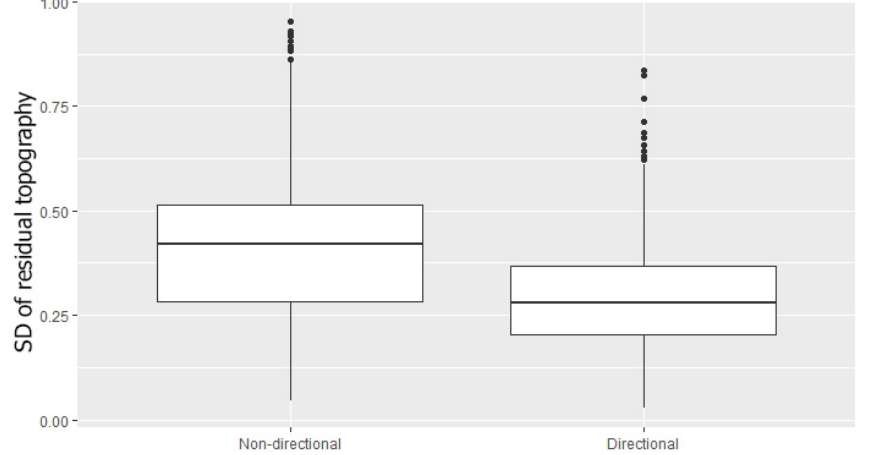
Figure 6. Surface roughness values calculated using non-directional and directional SD of residual topography. Using direction in the calculation of the surface roughness within the gullies resulted in values significantly lower ( p< 0 . 05) than those calculated with the non- directional method.